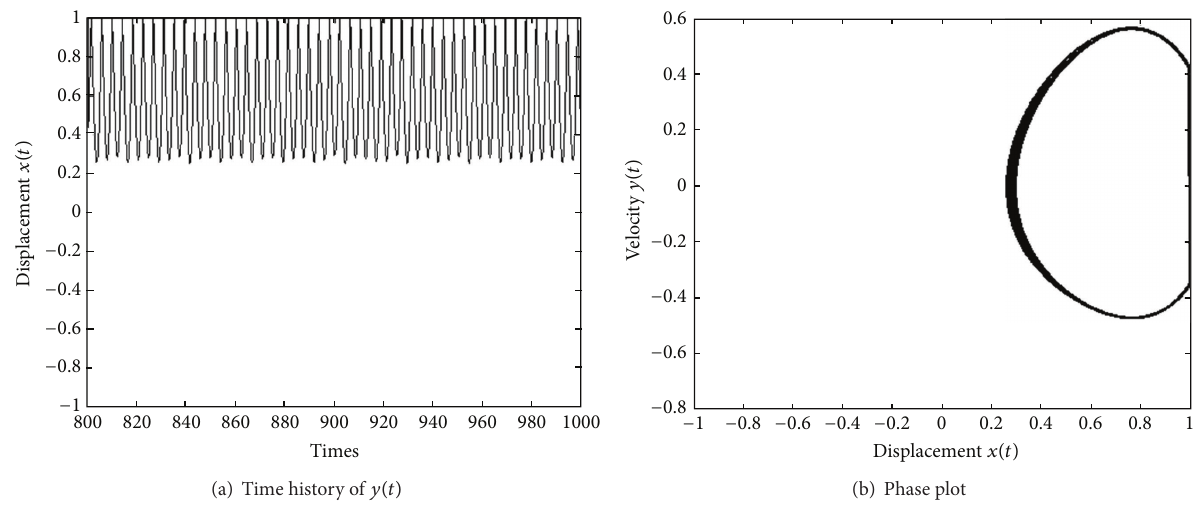
Figure 5: Numerical results of (1) ( 𝑓 1 = 2.5, 𝑓 2 = 0.05, 𝑥(0) = −0.4, ̇𝑥(0) = 2.5 ).